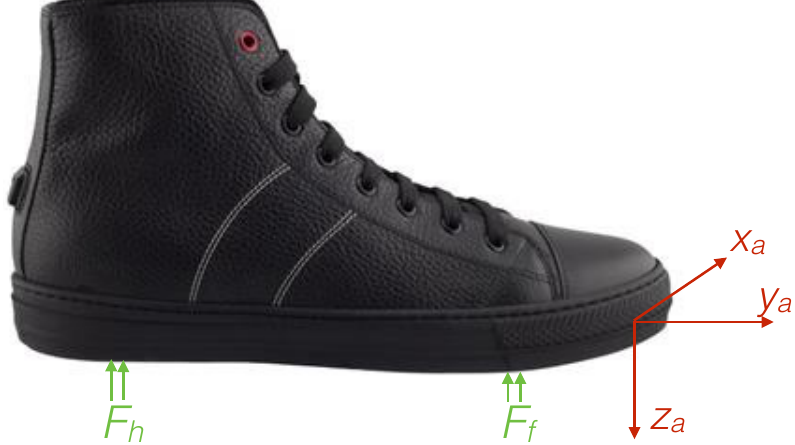
Figure 1. The FootMoov prototype. The green arrows indicate the location of the heel and forefoot force sensors (output F h and F f respectively). The local reference frame of the calibrated accelerometer (outputs ax , ay , az ) is reported in red ( x a , y a , z a ). In the rear part of the shoe it is possible to see the on/off switch and the mini-USB connector for battery